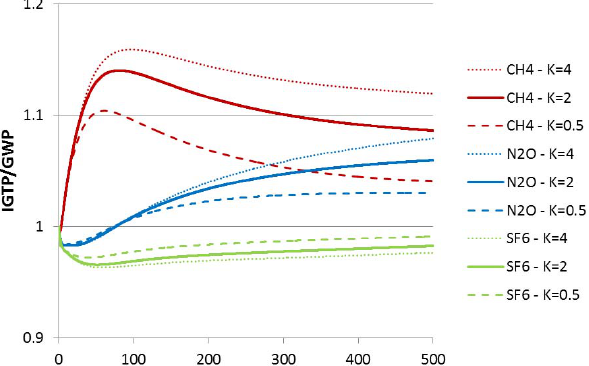
Fig. 2. IGTP/GWP ratio for CH 4 , N 2 O and SF 6 depending on ef- fective vertical heat diffusivity. K , the vertical heat diffusivity, is given in cm 2 s − 1 .